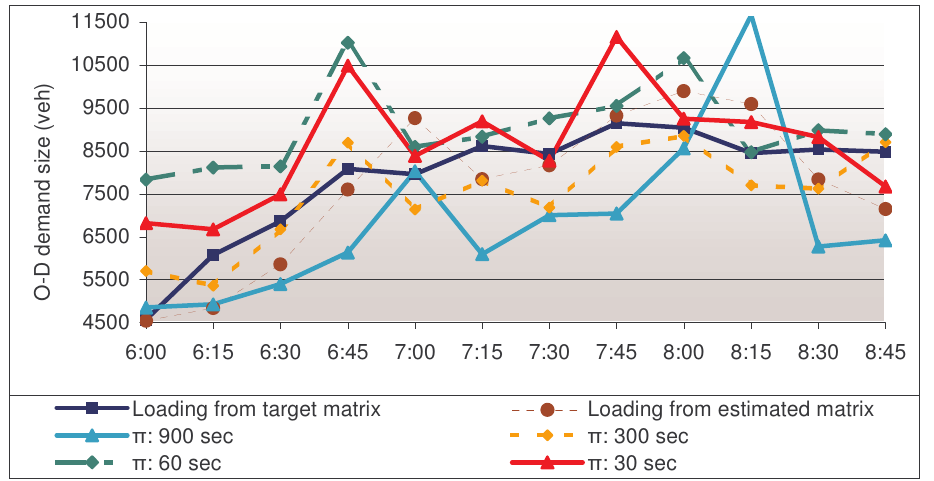
Figure 6. Changes in the O-D demand size over time for different information updating frequencies and loading